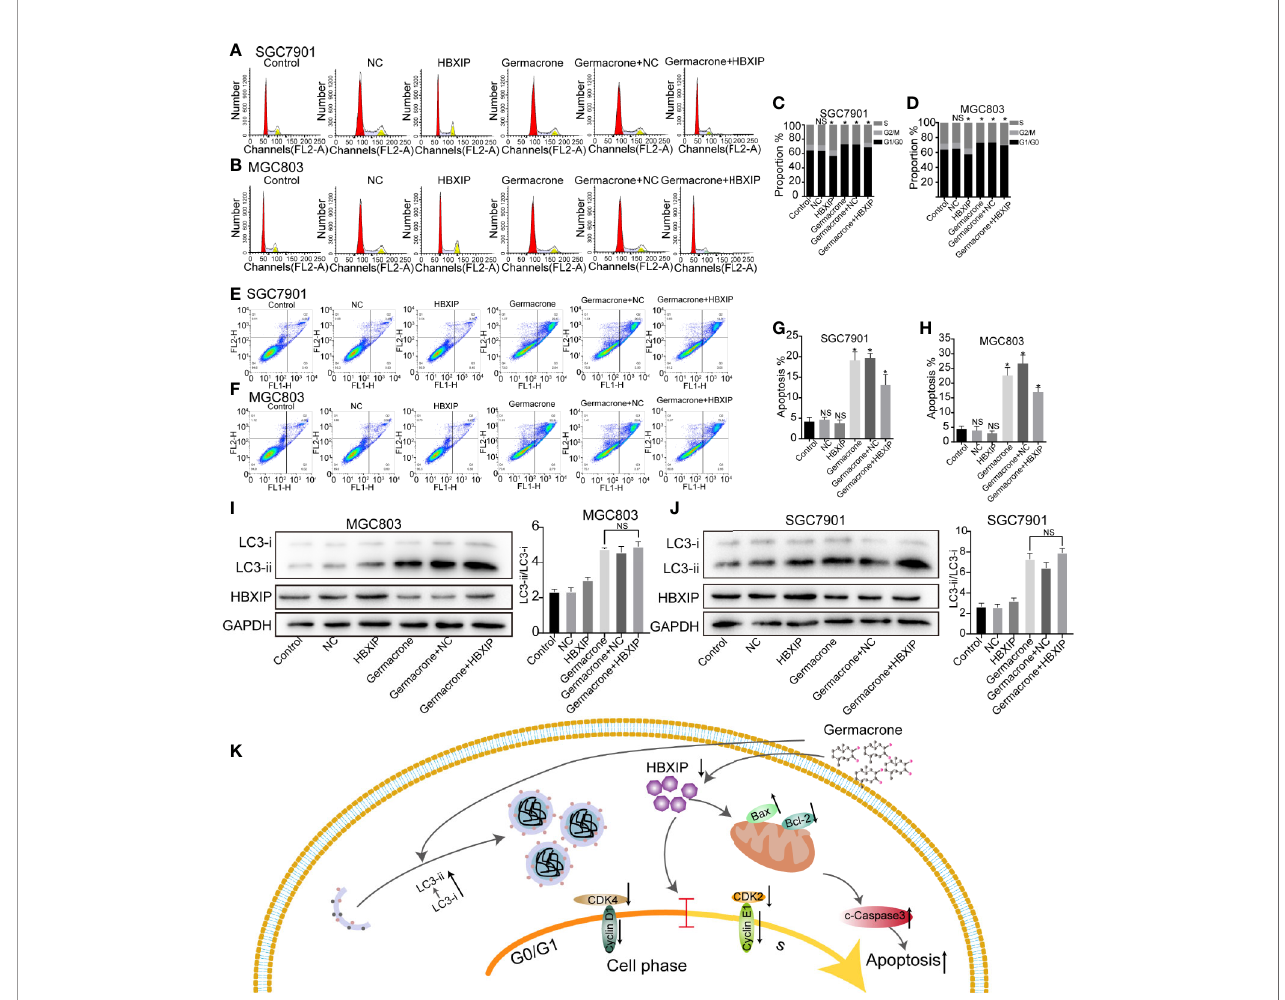
FIGURE 7 | Overexpression of HBXIP regulated autophagy and reversed the germacrone-induced cell cycle arrest and apoptosis. (A – D) Propidium iodide (PI) staining was used for fl ow cytometric (FCM) analysis of the effect of germacrone and overexpression of HBXIP on the cell cycle. (E – H) Annexin IV- fl uorescein isothiocyanate (FITC)/PI staining was used to detect the effect of germacrone and overexpression of HBXIP on apoptosis by FCM. (I, J) The expression of HBXIP, p-62, LC3I, and LC3II was detected by western blot. (K) A schematic of the effect of germacrone on gastric cancer cells. Germacrone inhibits gastric cancer cell proliferation involving HBXIP-mediated regulation of the cell cycle, apoptosis, and autophagy. Data are the means ± SD of three experiments. * P < 0.05; ns, not signi fi